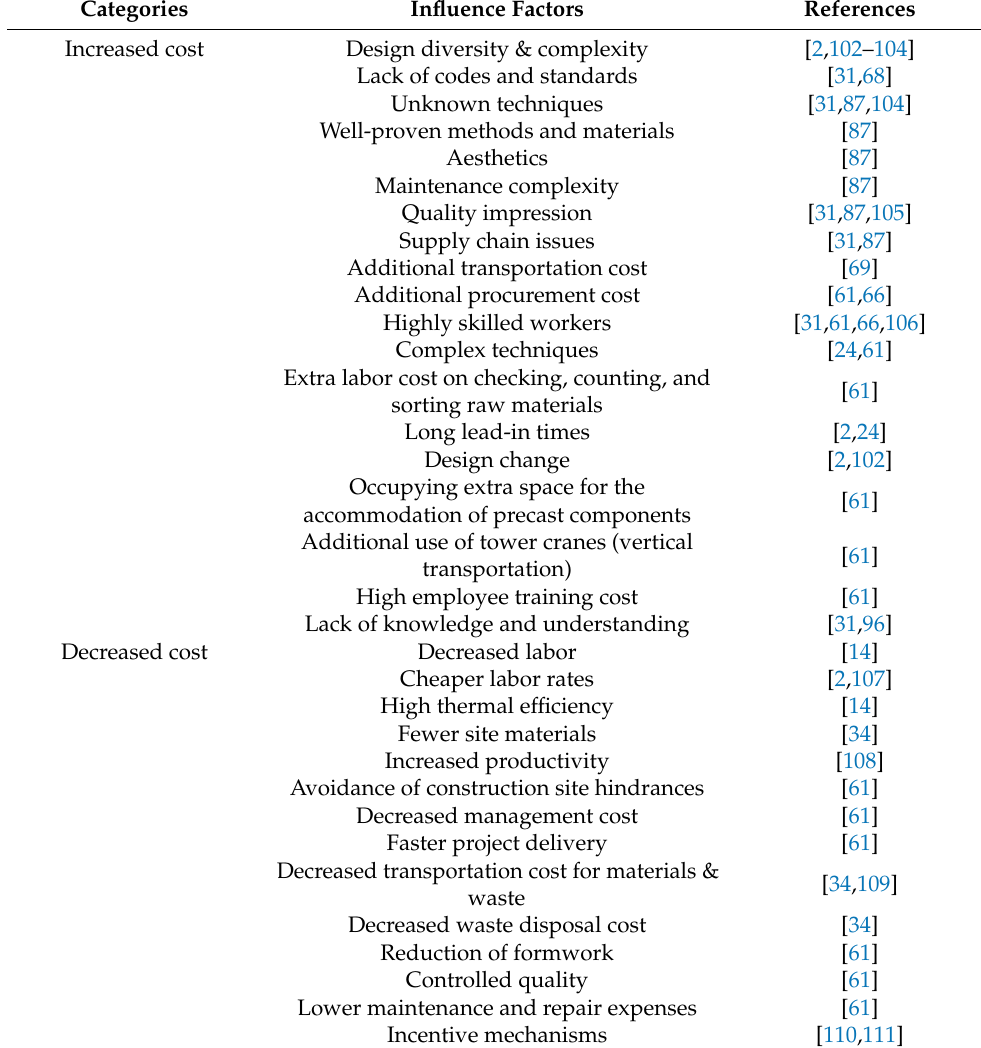
Table 3. Existing study on the key factors influencing the cost of